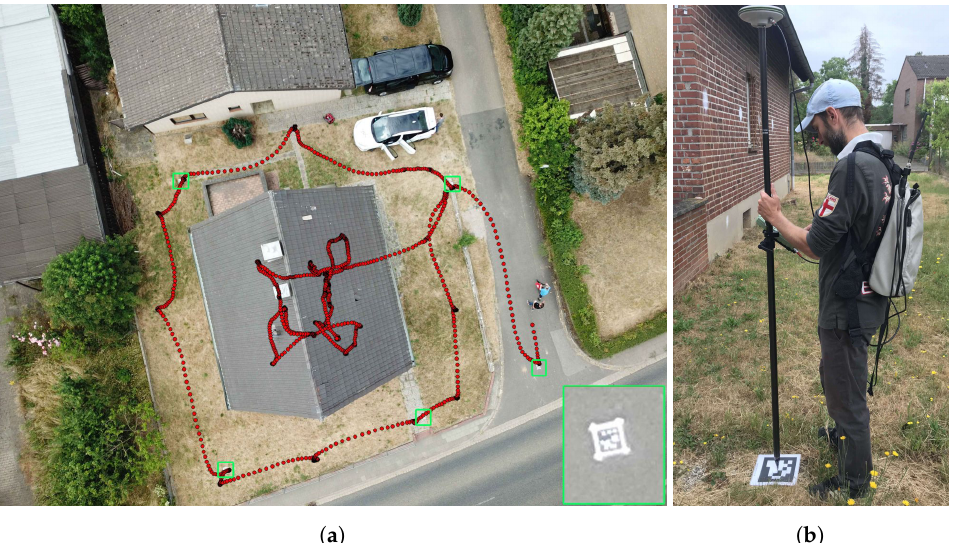
Figure 4. ( a ) One of 42 aerial images overlaid with DGPS georeferenced AprilTag targets showing GCPs (green rectangles) and a section of the IPS trajectory (red dots). ( b ) Leica 1200 DGPS